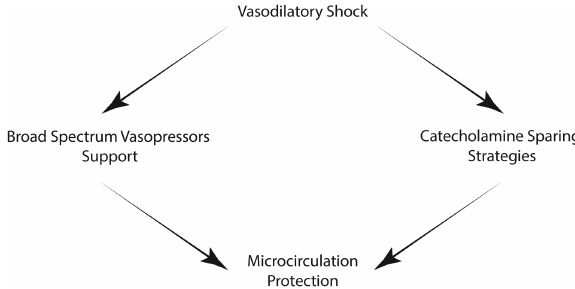
Figure 1. The overview of the desirable steps to better approach a critically-ill patient in the vasodilatory shock: (1) use of “broad-spectrum vasopressors,” (2) vasopressor-sparing strategy, and (3) microcirculation